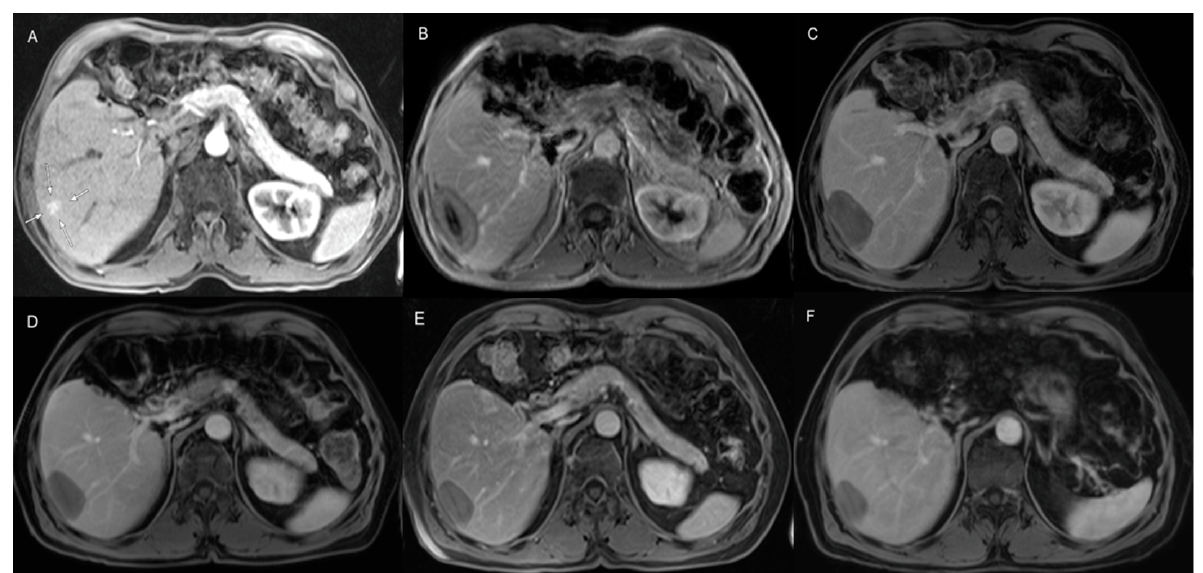
Figure 1. A 73-year-old male patient who developed intrahepatic recurrence 7 months after initially surgically resecting HCC. ( A ) pre-ablation contrast-enhanced MRI showed recurrent HCC lesion in liver segment 6 (white arrows). ( B ) A 24 h post-ablation MRI showed complete coverage of the recurrent tumor by the ablation area. ( C ) Three months post-ablation MRI. ( D ) Six months post-ablation MRI. ( E ) Twelve months post-ablation MRI. ( F ) Twenty-four months post-ablation MRI showed signi fi cant decrease in ablation area. The OS of this patient was 7.6 years after performing MWA for the recurrent HCC without developing LTP or IDR.